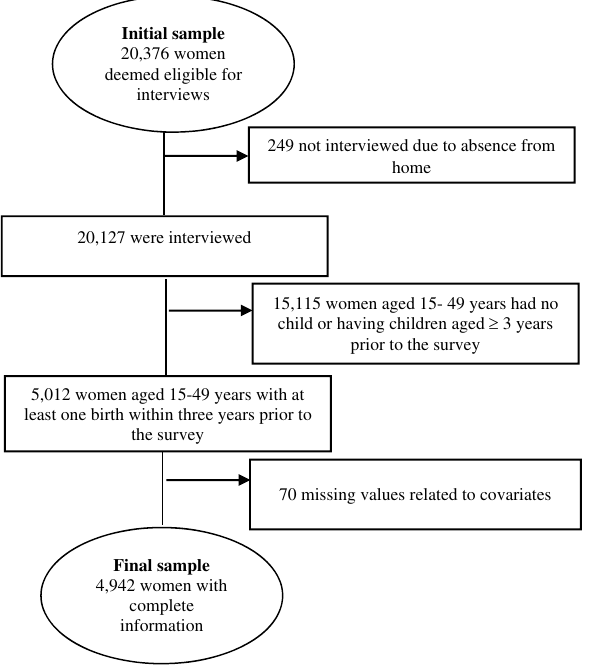
Figure 1. Study sample selection process: Bangladesh Demographic and Health Survey